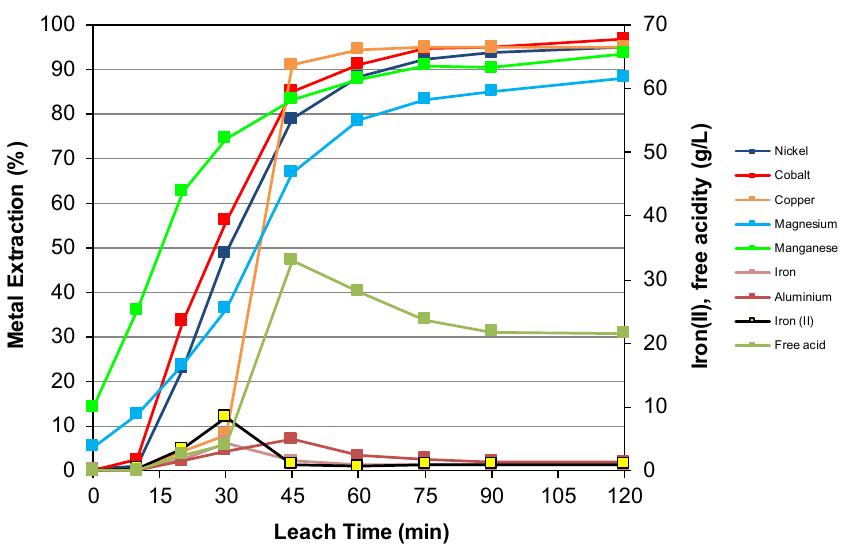
Figure 3. Metal extractions, ferrous iron concentration, and free acidity for samples taken during the co-processing of 30% w / w total, 7% nickel concentrate with 23% nickel laterite ore, in site water at 250 ◦ C with ~150 kPa O 2 overpressure.